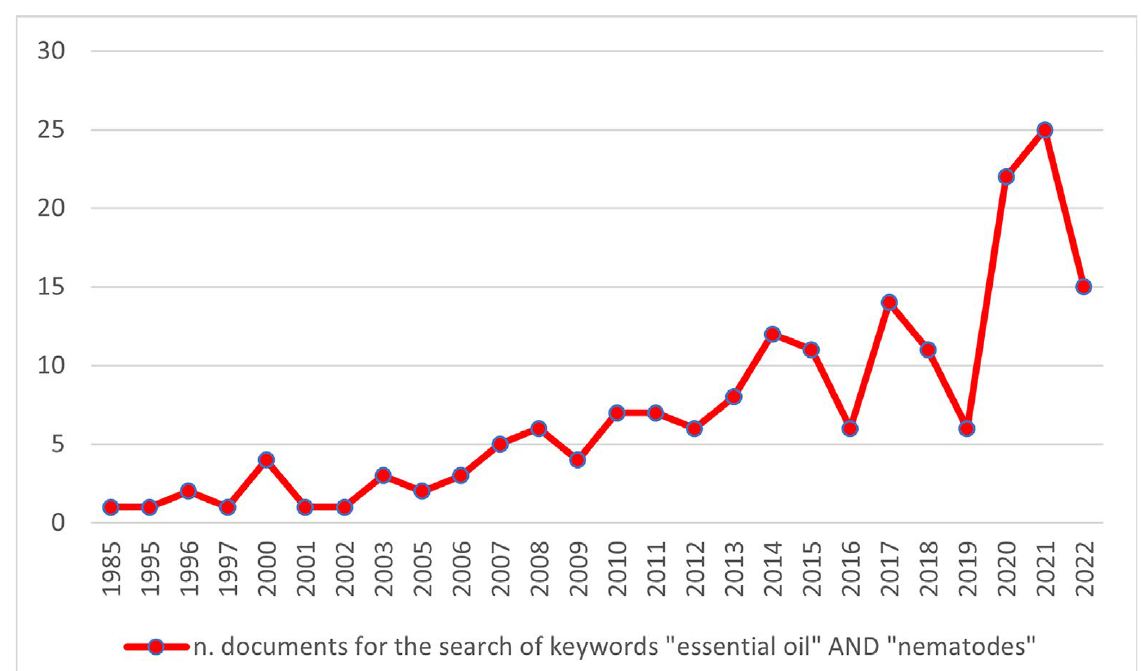
Figure 1. The total number of documents for the search of keywords “essential oil” AND “nematodes” in the Scopus database.